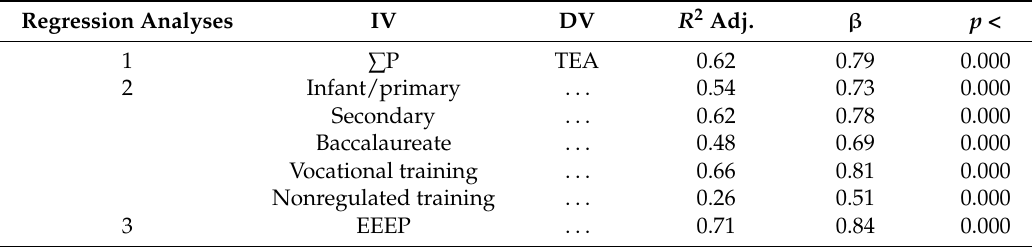
Table 5. Regression